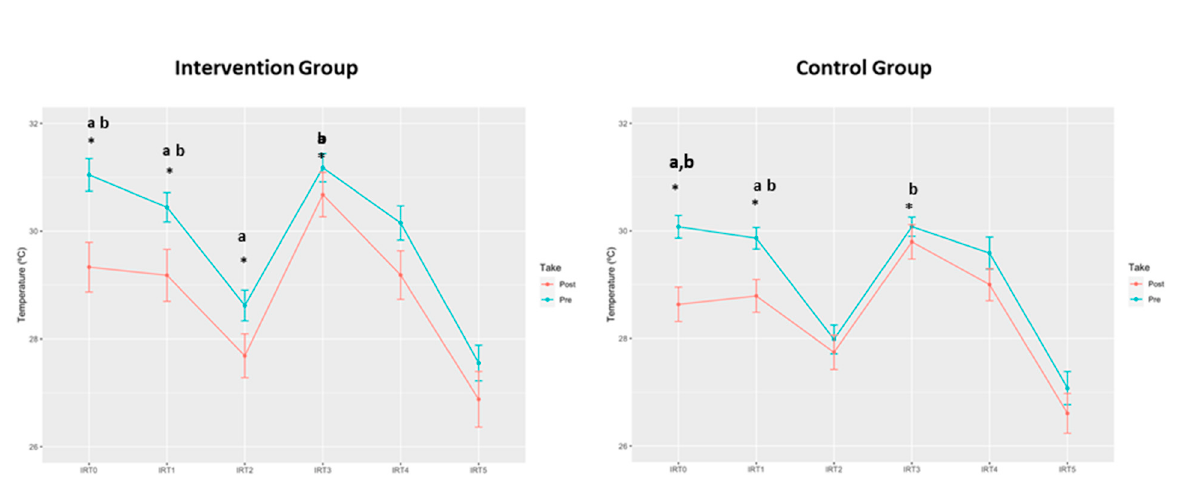
cooling down. Significant differences ( p < 0.05) are highlighted in bold.